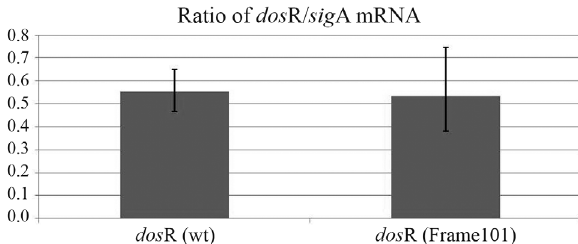
Figure 2 - Expression level of dos R using RTq-PCR. RNA was extracted from both 7-day rolling cultures of M. tuberculosis H37Rv and Fame101, then reverse transcribed to cDNA. RTq-PCR was then carried out using the DyNAmo SYBR Green qPCR kit and DNA Engine Opticon 2 System. Expressionlevelswerenormalizedtothoseof sig AmRNA.Wefoundthat the ratio of dos R/ sig A mRNA of the constitutively expressed dos R in Fame 101 (0.54), is not significantly different from that of the wild-type (0.55). Levels of dosR were undetected in the mutant.